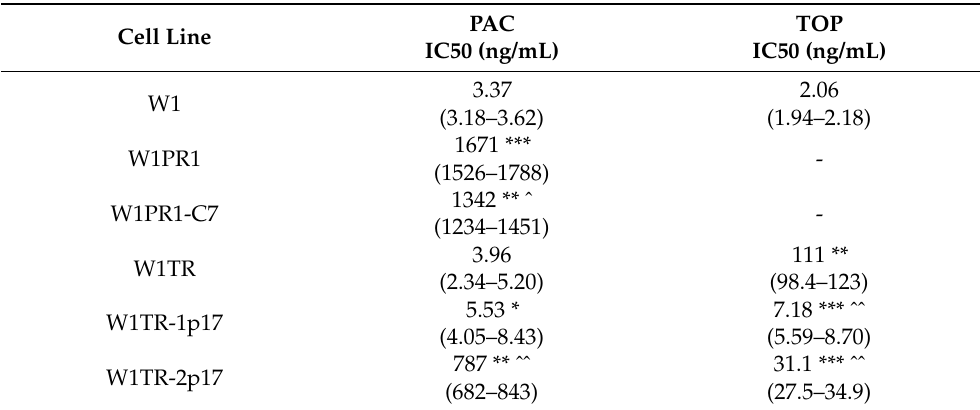
*—difference between drug sensitive (W1) and resistant cell line, the values were considered significant at * p < 0.05, ** p < 0.01, and *** p < 0.001; ˆ—difference between drug resistant cell line and cell line with changed